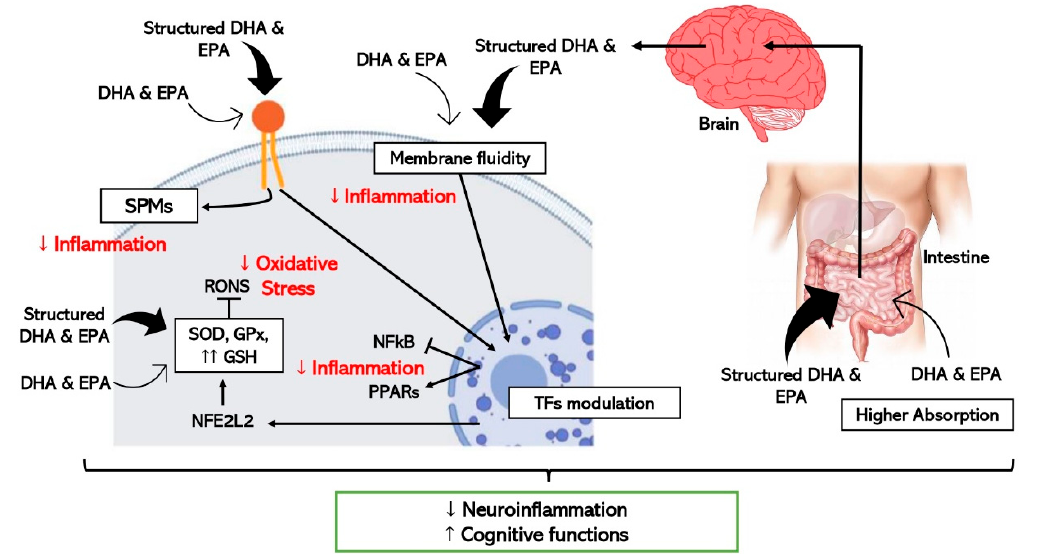
Figure 2. Schematic representation of the hypothetic mechanisms through which ω -3 LCPUFAs reduce neuroinflammation and improve cognitive function by modulating inflammation and oxidative stress in brain cells. Thick arrows express the enhanced effect of the structured forms of DHA and EPA (TFs, transcription factors).